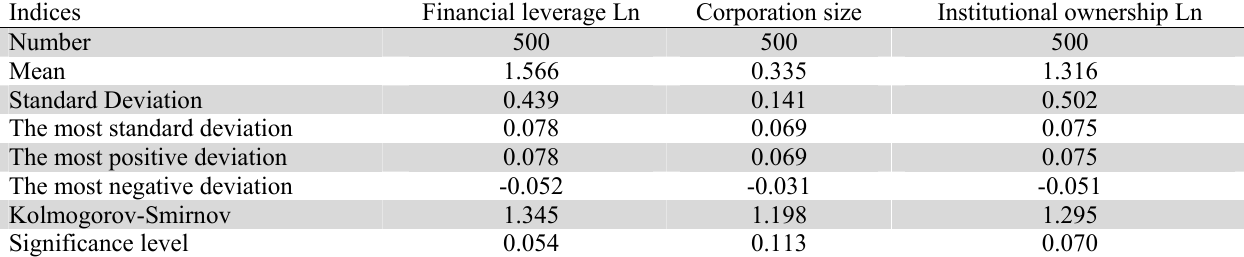
The summary of Kolmogorov-Smirnov test